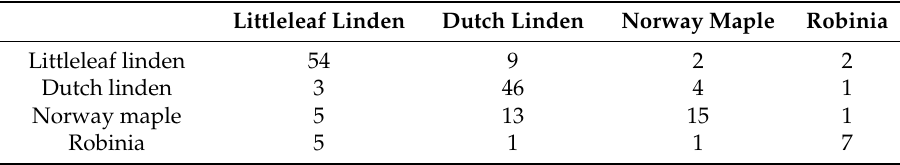
Table 7. Confusion-Matrix of tree species classification by ALS data.